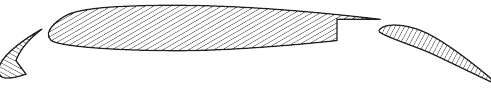
Figure 1. Two-dimensional view of a wing with a slat and single slotted flap